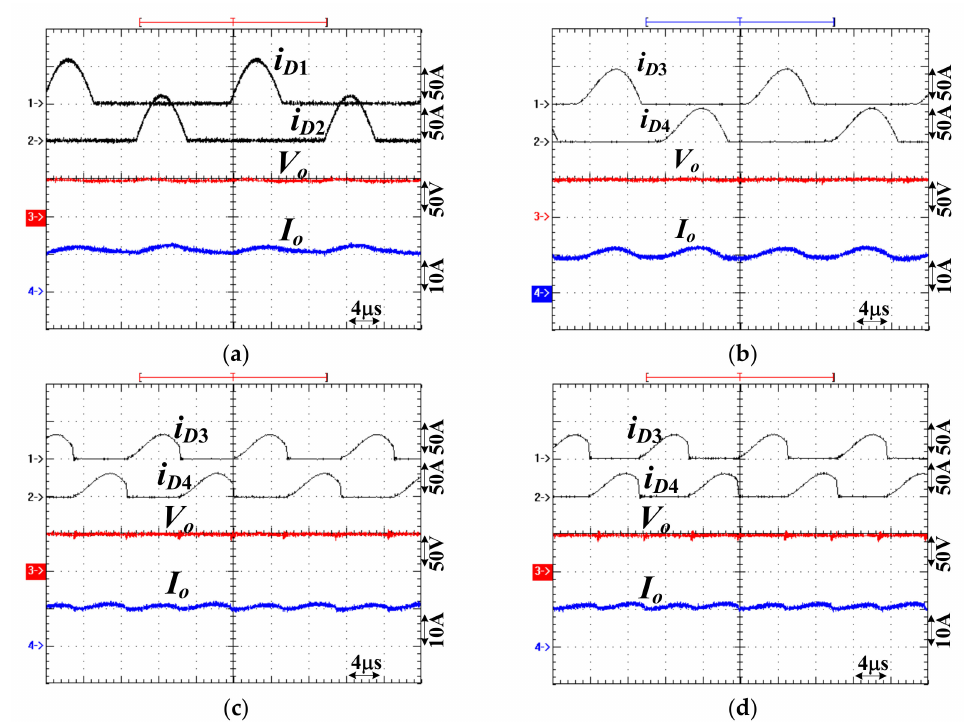
Figure 12. Experimental results of the secondary-side currents and load voltage at 100% load; ( a ) 50 V input (low voltage range); ( b ) 110 V input (medium voltage range); ( c ) 190 V input (medium voltage range); ( d ) 400 V input (high voltage range).